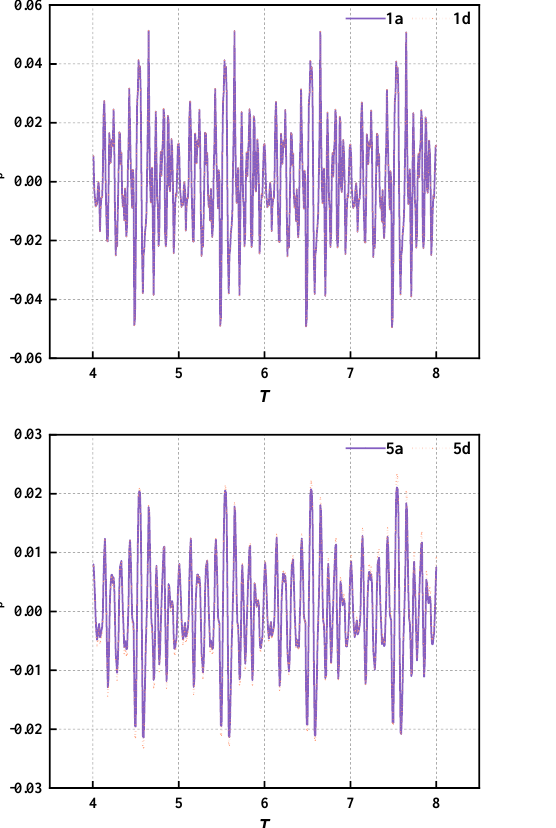
Figure 11. Time domain diagram of water pressure fluctuation under diversion condition.